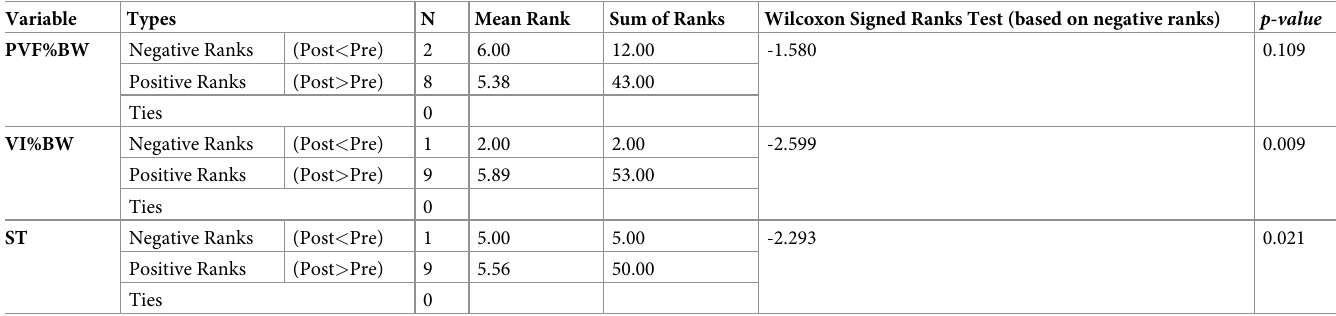
Table 3. GRFs: Ranks and Wilcoxon signed rank test values–group A: Product 2076.